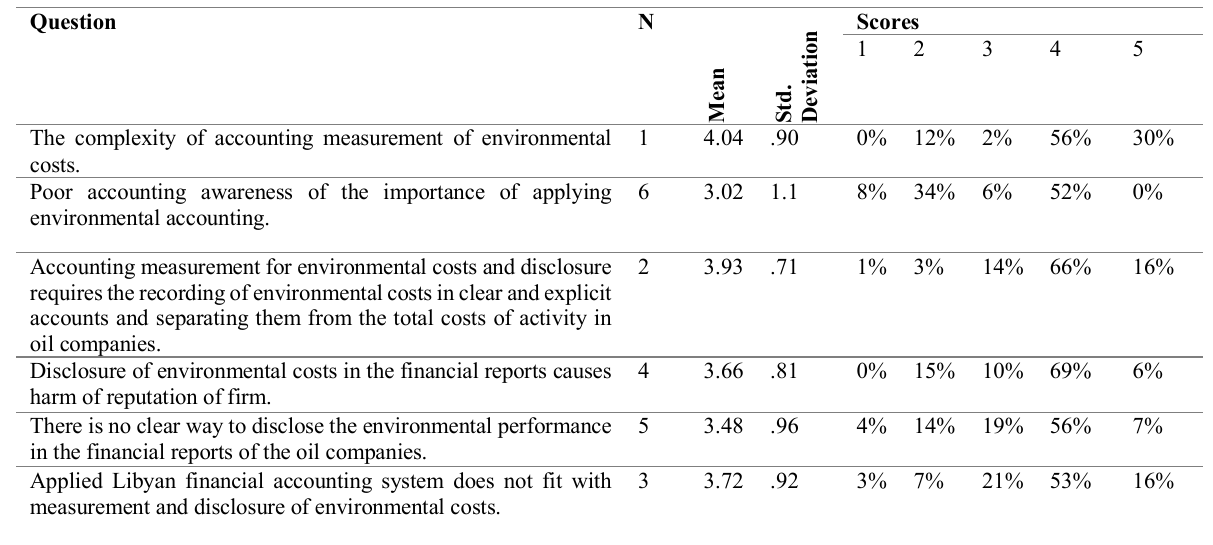
Table 7: Obstacles to the application of measurement and disclosure of environmental costs